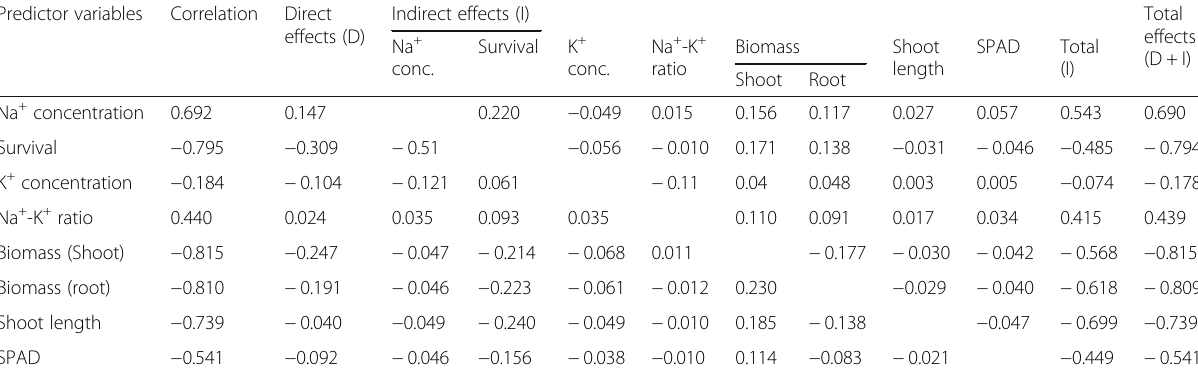
Table 2 Correlation and path coefficients for direct and indirect effects of Na + concentration, survival, K + concentration, Na + -K + ratio, shoot and root biomass, shoot length and SPAD readings on SES scores in an F 2:3 population of a cross between Capsule (salt tolerant) and BR29 (salt sensitive) grown under salt-stress at seedling